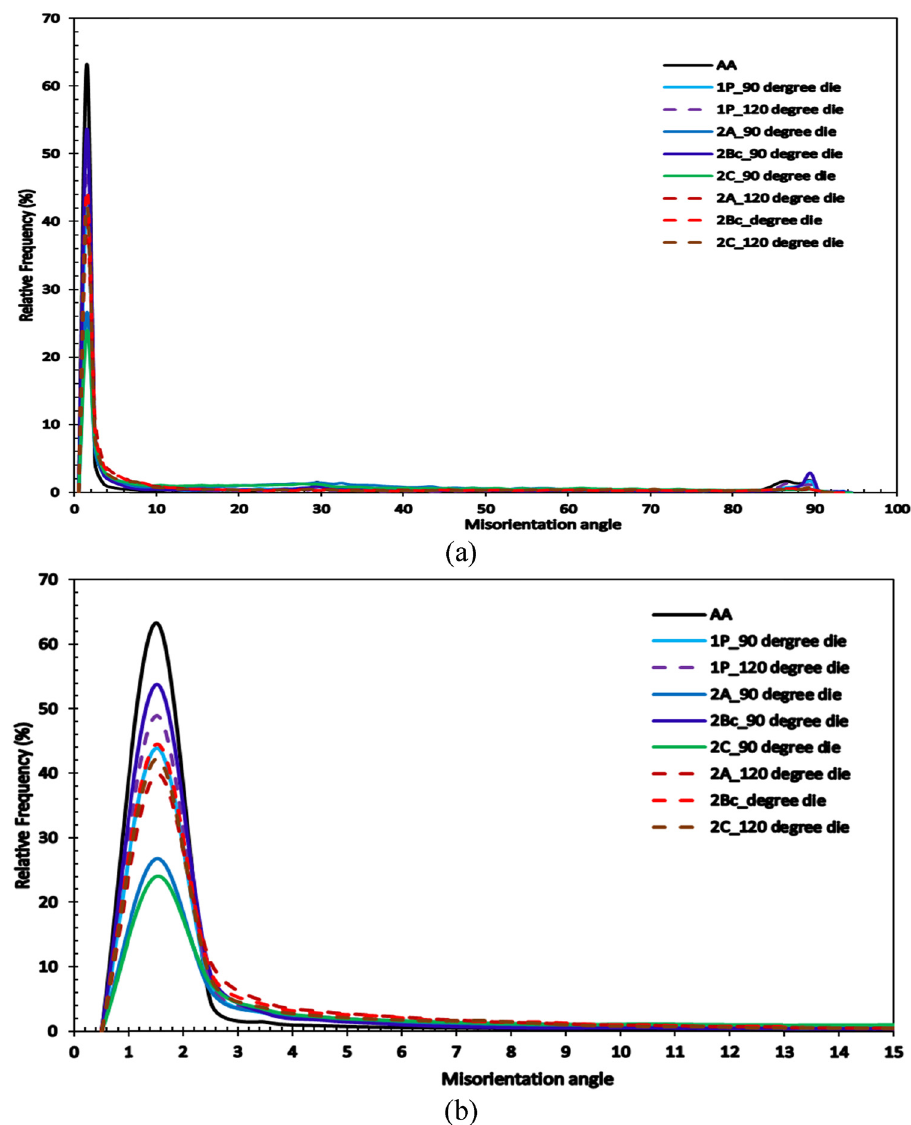
Figure 7: ( a ) Misorientation angle distribution of the AA and ECAPed billets of pure Mg using di ff erent die angles of ϕ = 90° and ϕ = 120° through di ff erent route types and ( b ) magni fi cation of the misorientation angle